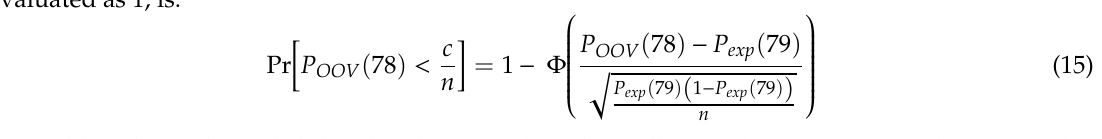
(cid:18) (cid:19) P exp ( 79 ) ( 1 − P exp ( 79 ) ) (cid:3017) (cid:3280)(cid:3299)(cid:3291) ((cid:2875)(cid:2877))(cid:4672)(cid:2869) (cid:2879) (cid:3017) (cid:3280)(cid:3299)(cid:3291) ((cid:2875)(cid:2877))(cid:4673) P exp ( 79 ) , follows the distribution N ; knowing the weight (cid:4679) ; knowing follows the distribution 𝒩 (cid:4678)𝑃 (cid:3032)(cid:3051)(cid:3043) (79), n n (cid:3041) (cid:3041) < P ( 78 ) . OOV n